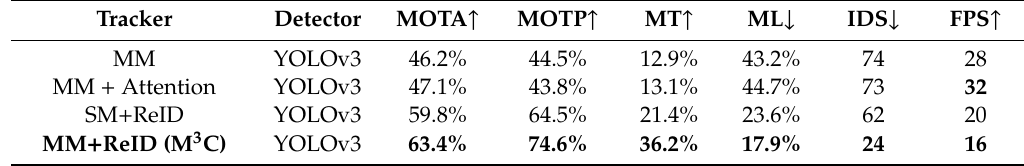
Table 5. Results of the ablation study. multimodel (MM), single model (SM), and re-identification (ReID) denote appearance model, multimodel filter, single model filter, Ship-ReID,